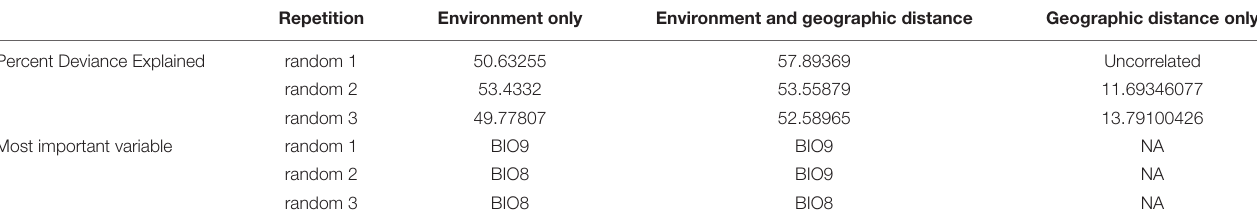
TABLE 2 | Results of the generalized dissimilarity modeling analyses.